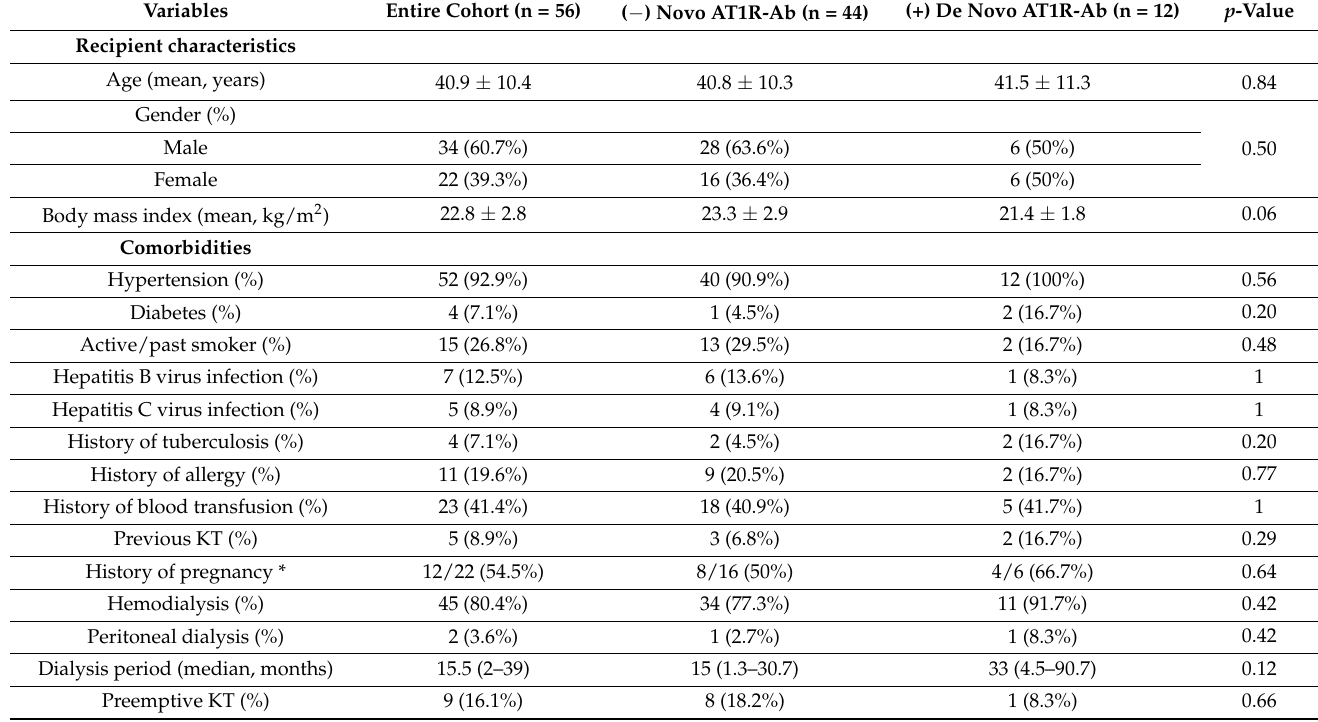
Table 1. Cohort characteristics and those according to the presence of de novo